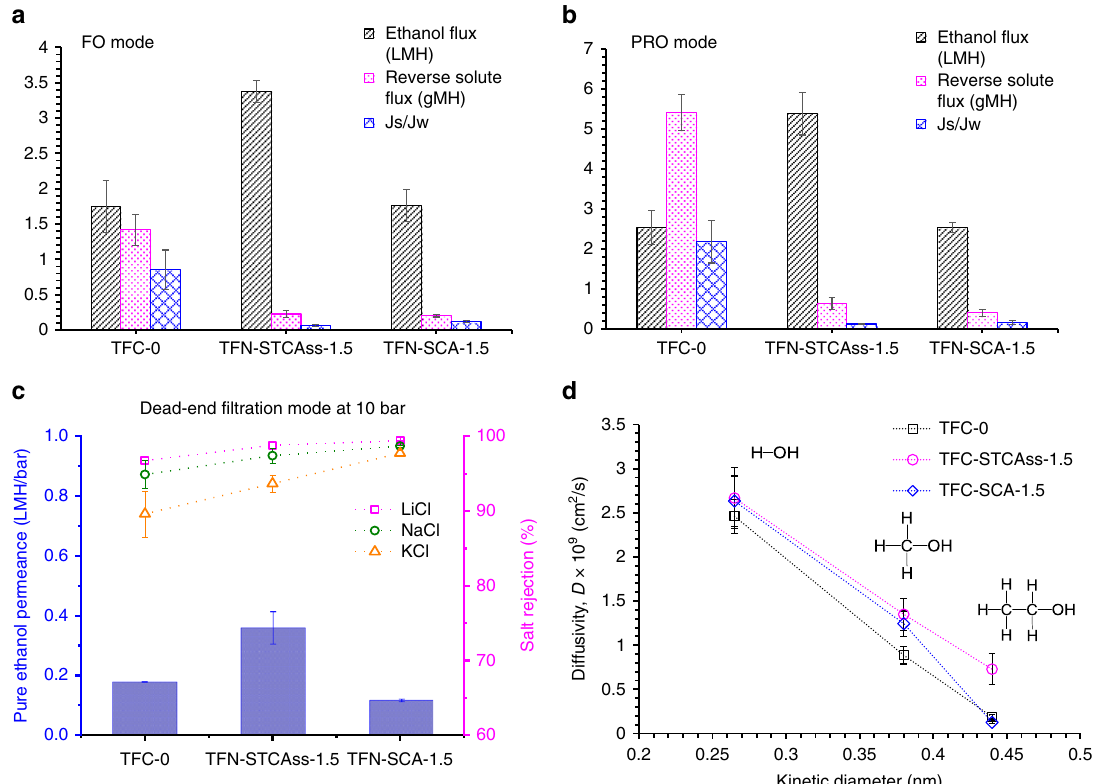
Fig. 6 Separation performance and transport properties of TFC-0, TFN-STCAss-1.5, and TFN-SCA-1.5. OSFO performance for a FO mode and b PRO mode, as well as c transport properties and d diffusivities of water, methanol, and ethanol in TFC-0, TFN-STCAss-1.5, and